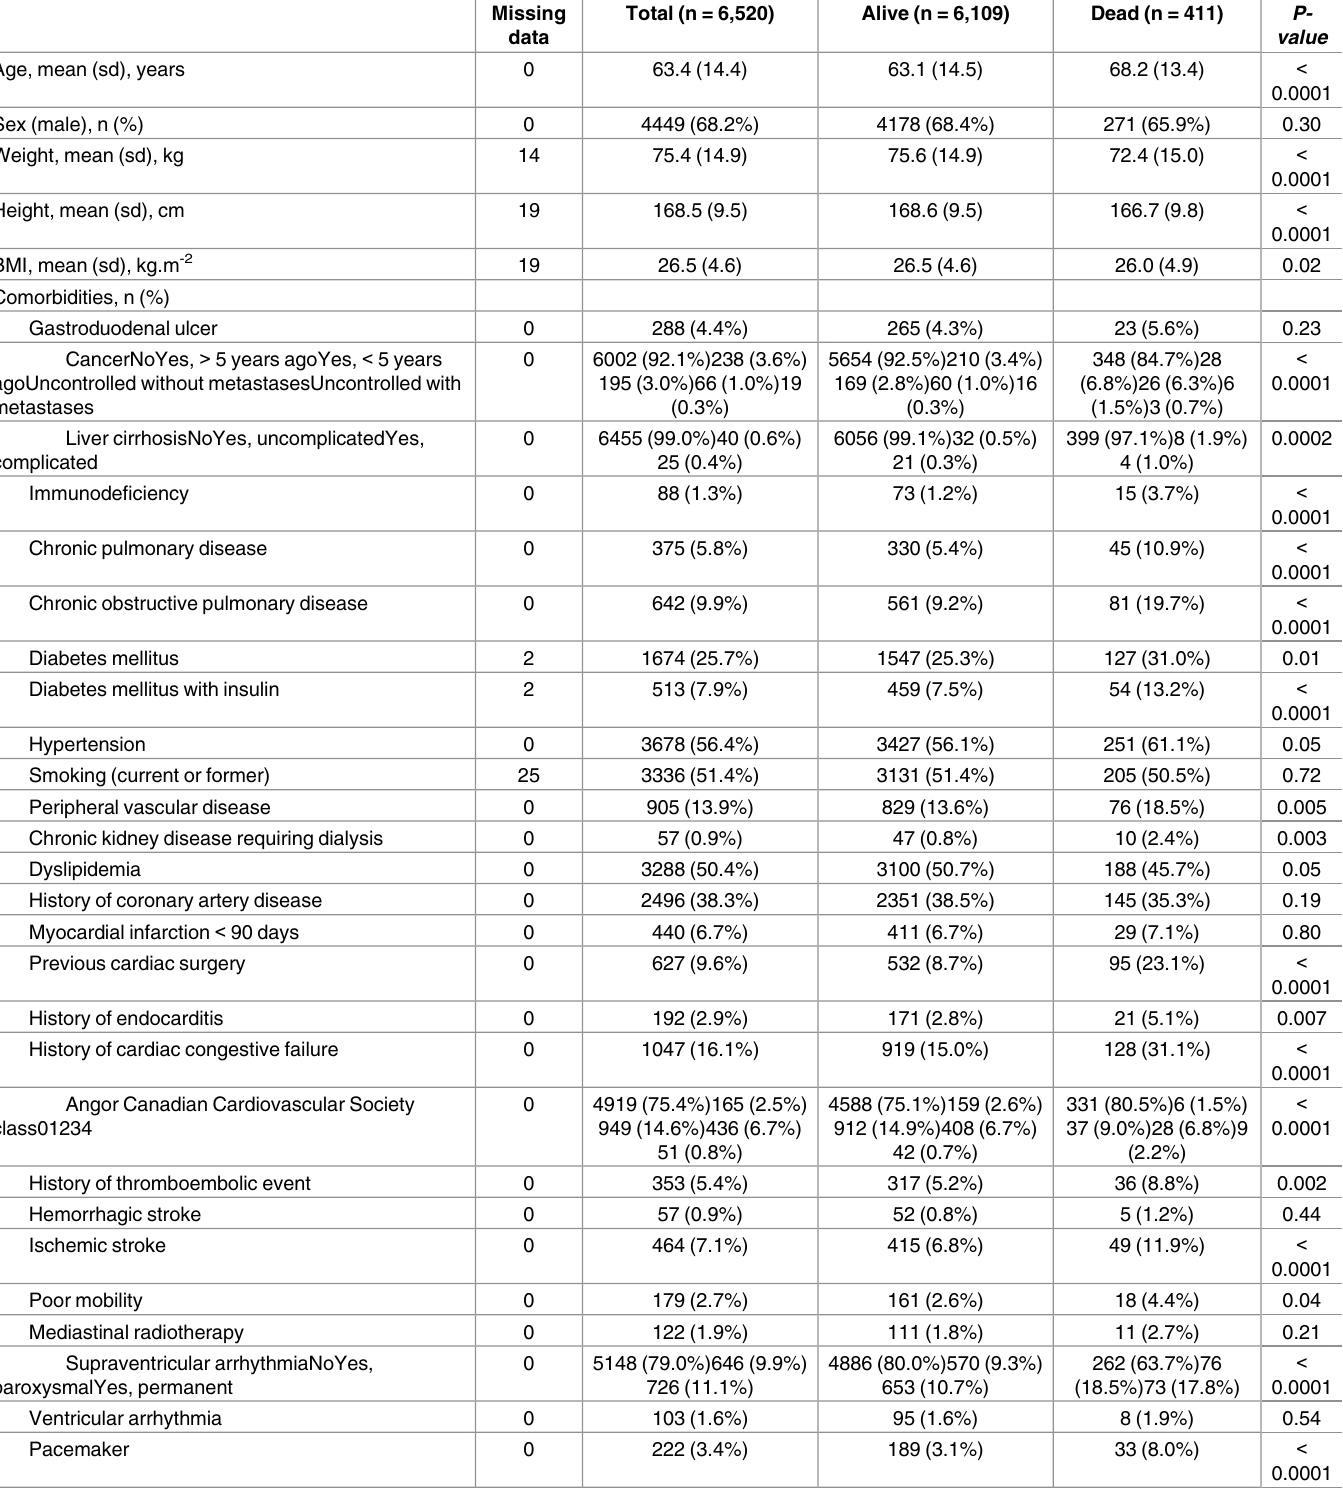
Table 1. Characteristics of patients at admission and evolution in ICU (whole